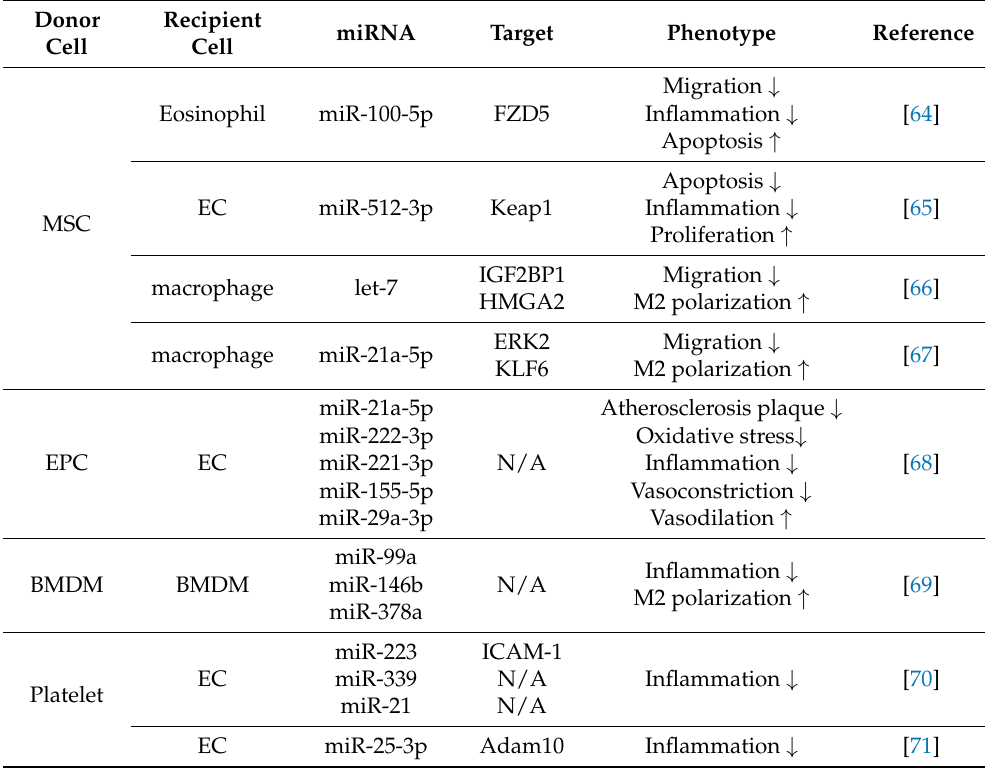
Table 1. Exosomal miRNAs with anti-atherosclerotic